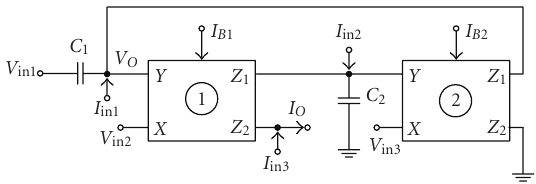
Figure 2: Proposed dual-mode universal filter.